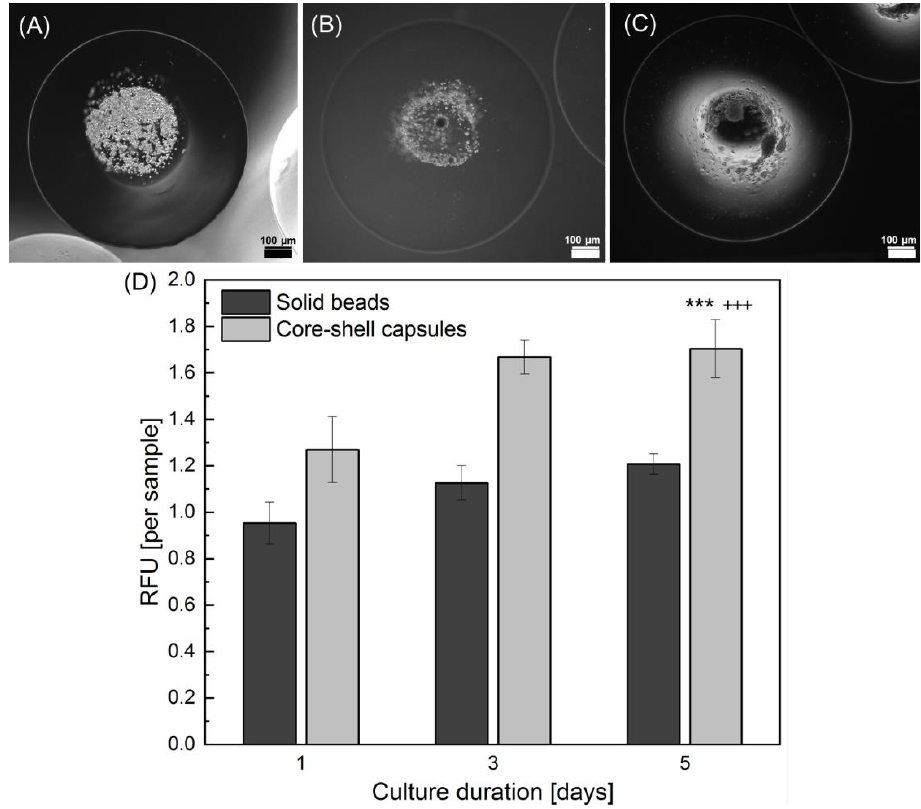
Figure 6. Human dermal MSCs encapsulated in core-shell capsules and solid beads. HdMSCs within core-shell capsules after encapsulation ( A ) and on day 3 ( B ) and 5 ( C ) in culture. ( D ) Metabolic activity of hdMSCs encapsulated in core-shell capsules and solid beads during culture for 5 days assessed by Alamar Blue test. Statistical analysis was performed using one-way Analysis of Variance (ANOVA) ( p = 0.05) and a Tukey’s multiple comparison test. The data are presented as a mean and standard deviation. In ( D ) *** data are significantly different ( p < 0.001) compared to solid beads on days 1, 3 and 5, +++ data are significantly different ( p < 0.001) compared to core-shell capsules on 1st and 3rd day of culture. The outer diameter of the capsules is about 1000 µm, whereas the core diameter is approximately 420 µm. Scale bars are 100 µm.